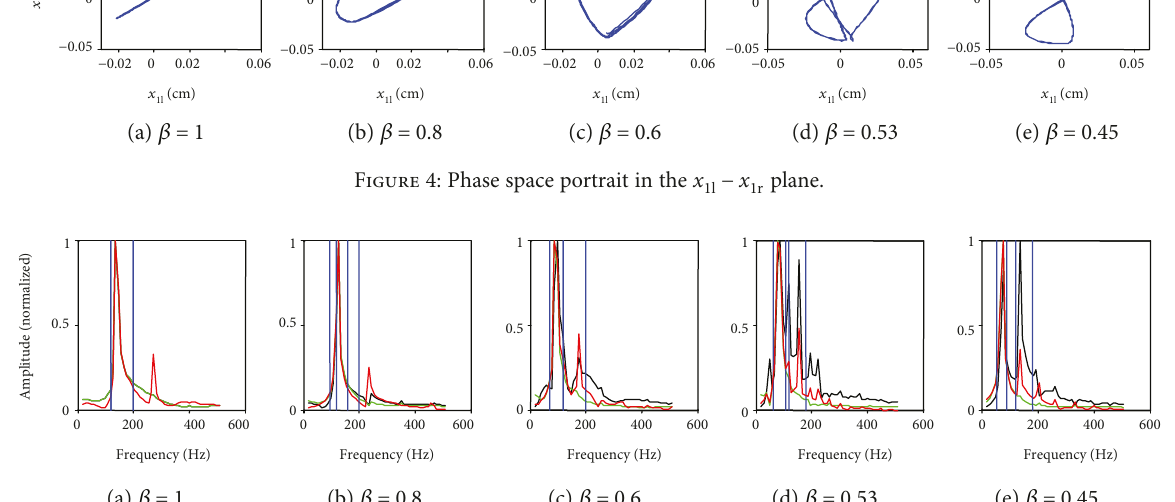
Figure 5: Fourier spectra corresponding to displacement of the two lower masses and the normalized glottal volume fl ow rate with P s = 0 8 kPa. Volume fl ow rate and left and right mass displacement are represented by the red, black, and green lines, respectively. Vertical dash lines represent the two left vocal cord natural frequencies, and the dash-dot lines represent those of the right vocal